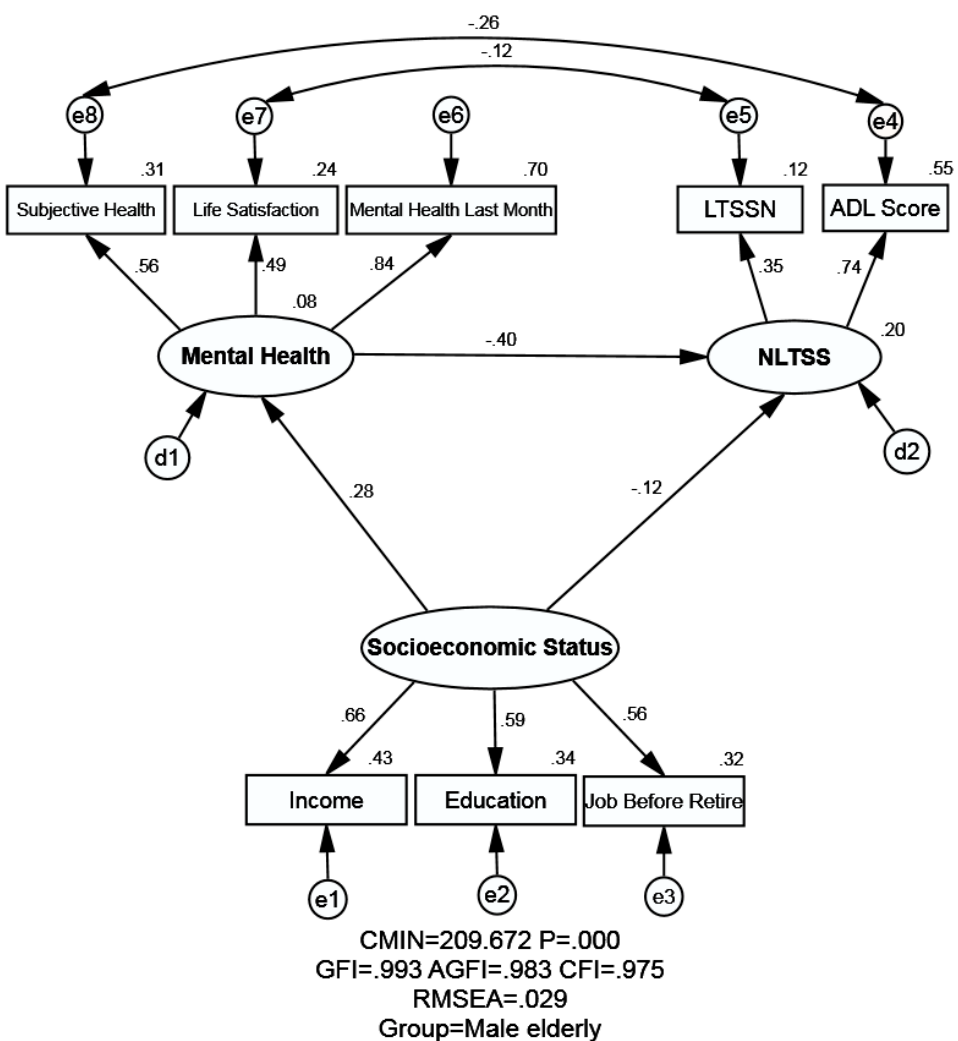
Figure 1. Structural equation modeling analysis of the association between SES, mental health and NLTSS of the male elderly ( n = 7070). Employing the cross-sectional data, relationship between SES, mental health and NLTSS were analyzed. Arrows indicate the associations and directions between variables, double curved arrows indicate correlation between each factor. All parameter estimates were statistically significant ( p < 0.001). Note: χ 2 = Chi square; GFI= Goodness of Fit Index; AGFI = Adjusted Goodness of Fit Index; CFI = Comparative Fitness Index; RMSEA=Root-mean Square Error of Approximation; LTSSN = Long-term Services and Supports needs; SES = Socioeconomic Status; NLTSS = Need for Long-term Services and